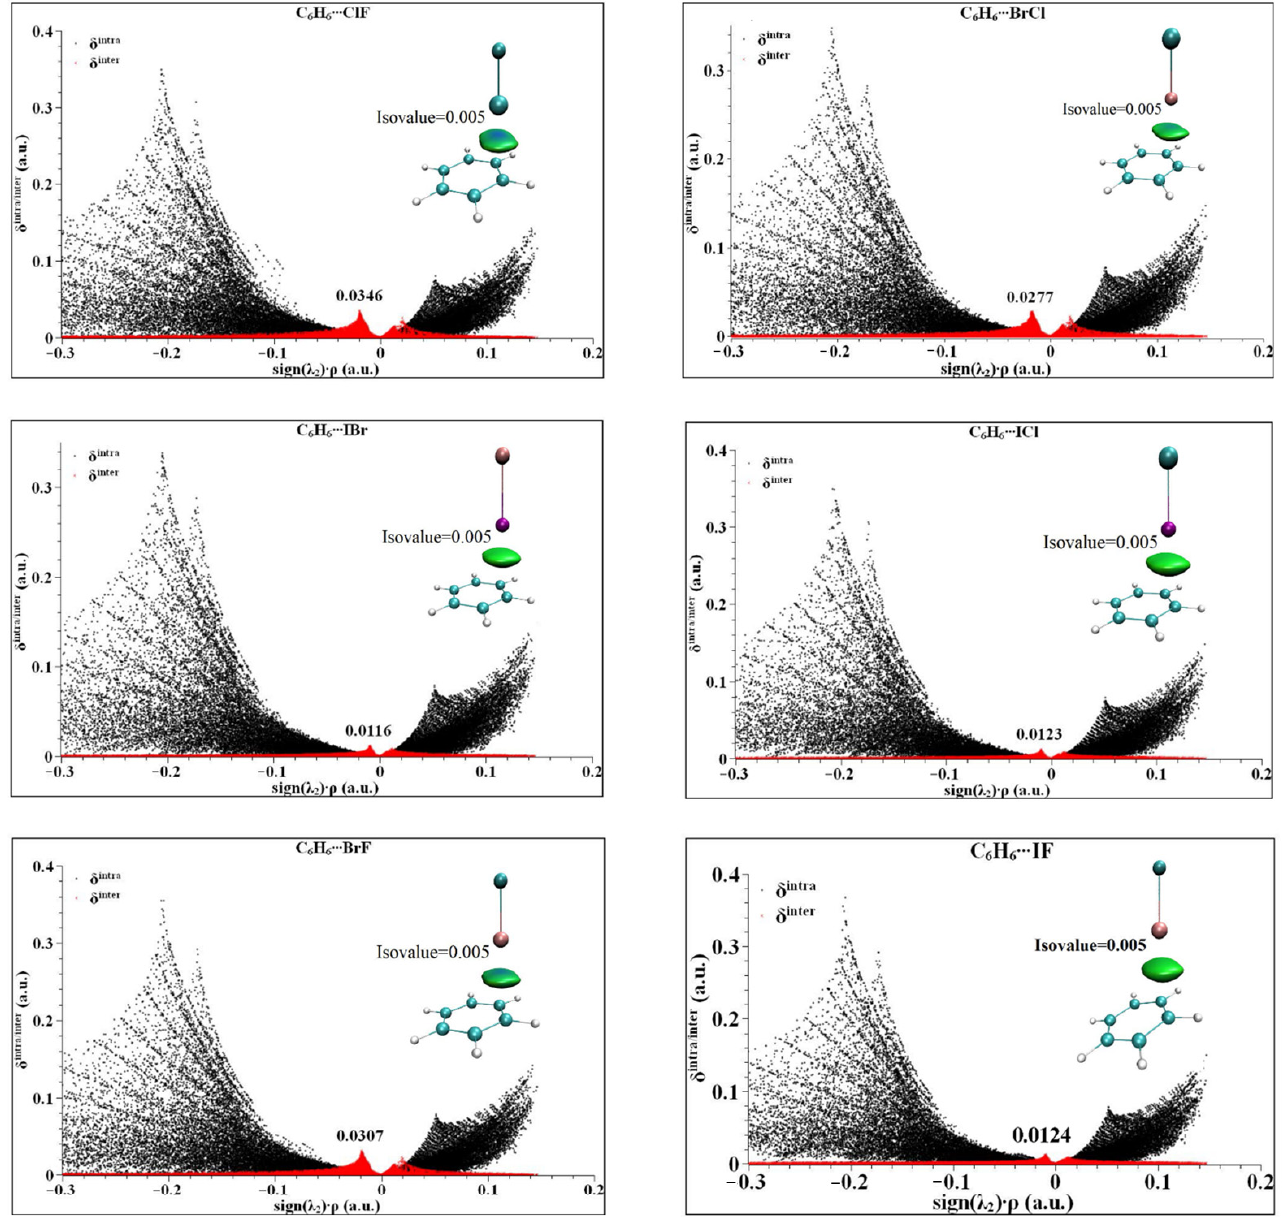
Figure 5. The IGM analysis and color plots of complexes between heteronuclear halogen XD (ClF, BrCl, IBr, ICl, BrF and IF) and